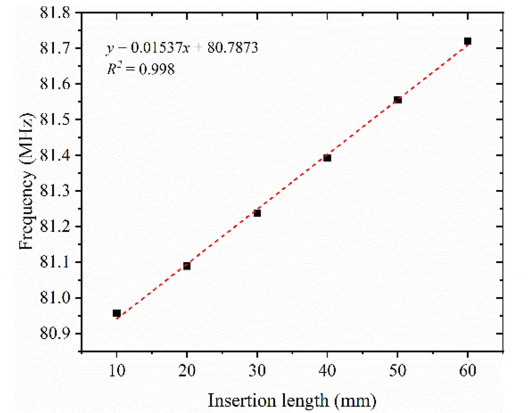
Figure 13. Analysis of tuners.